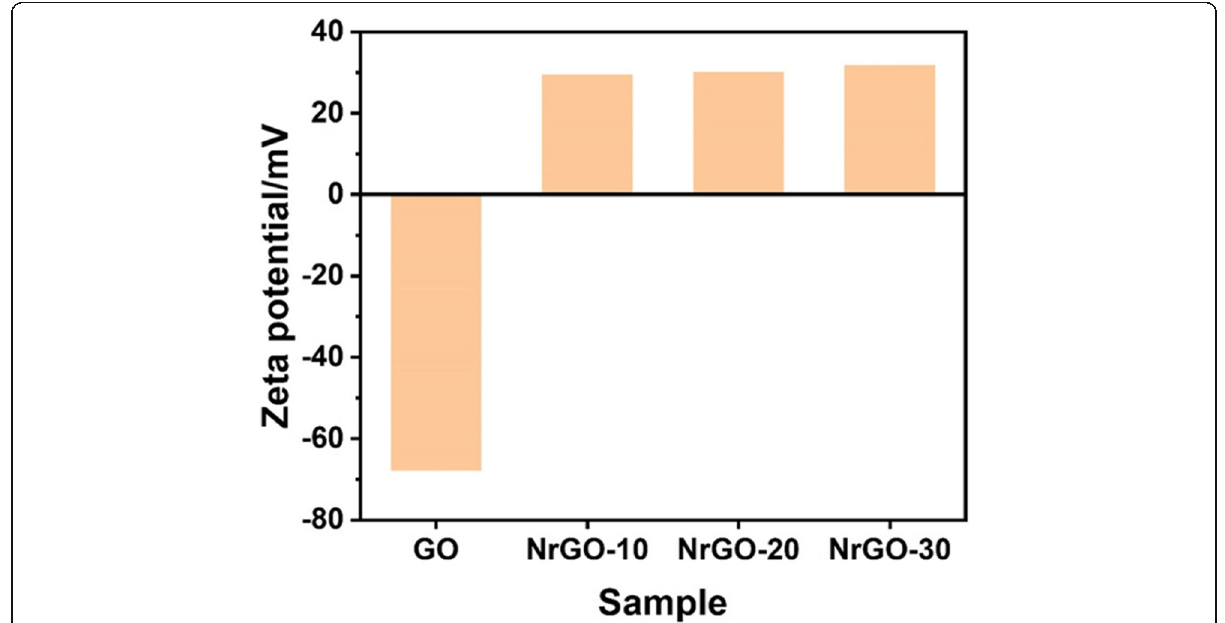
Fig. 4 Zeta potential test of GO and NrGO samples